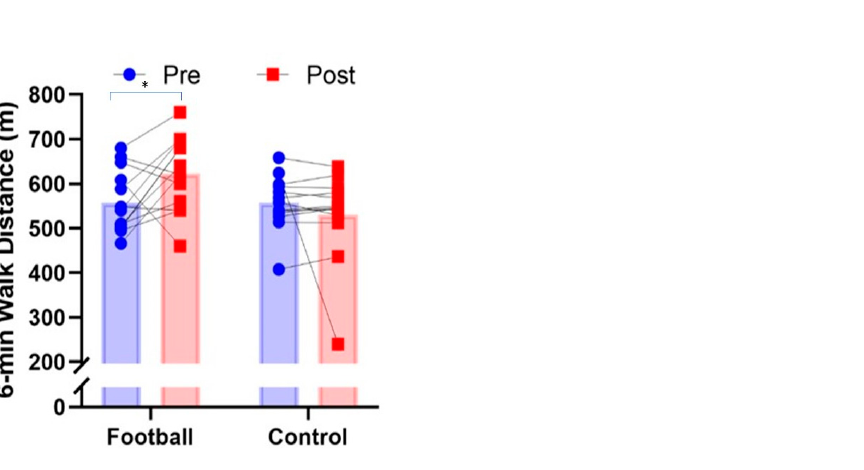
Figure 4. Group mean and individual performance for 6 min walk test performance (m) before and after in recreational football for health intervention group and matched controls (* p < 0.05).